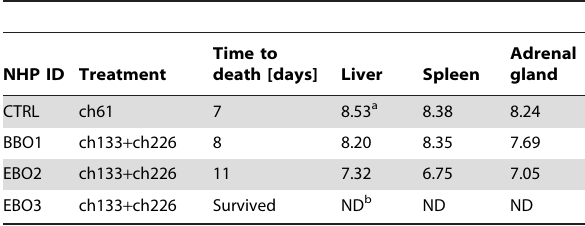
Table 1. Virus titers in tissue samples collected from euthanized animals during the prophylactic treatment study.